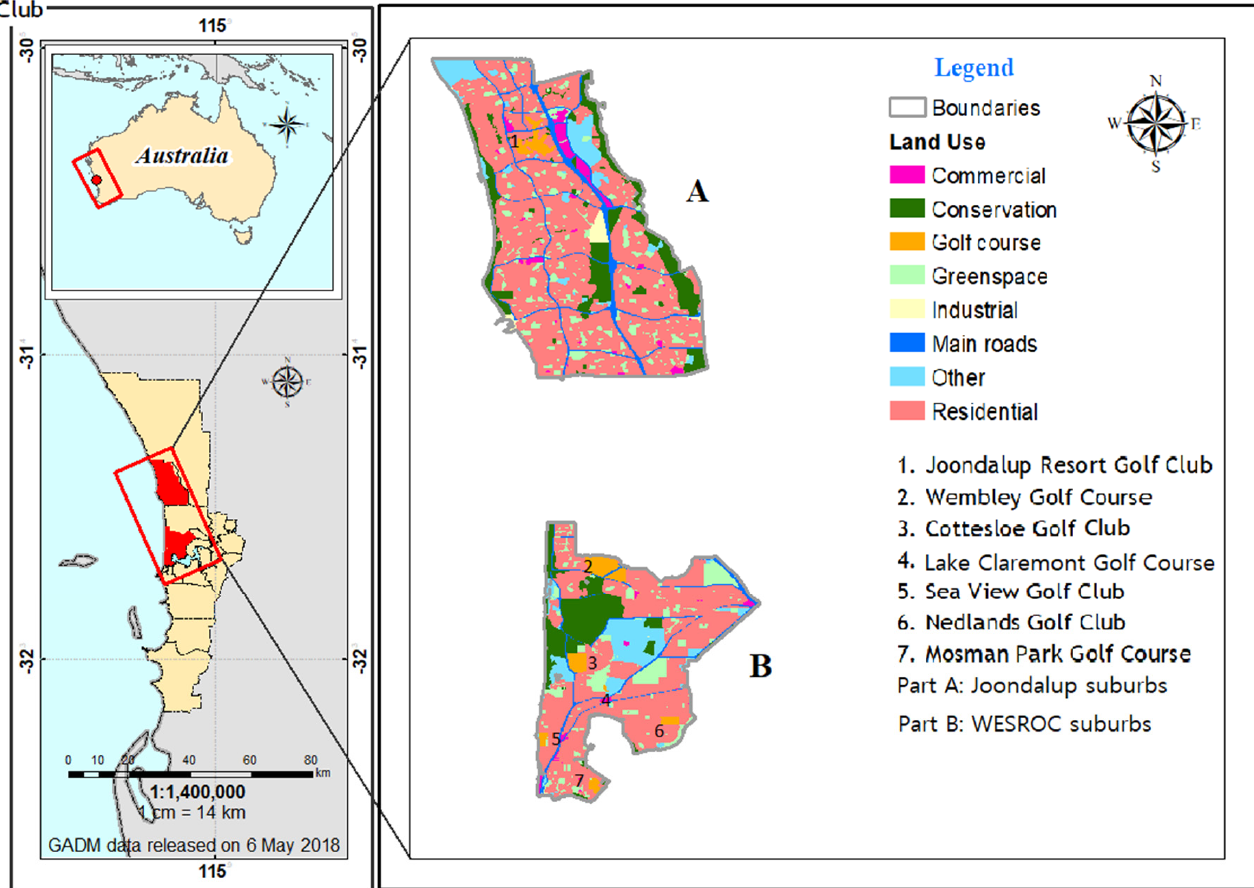
Figure 1. Map showing land use categories and the location of golf courses in the two study regions of the Perth Metropolitan Region. Table 1. Key characteristics of the seven golf courses.